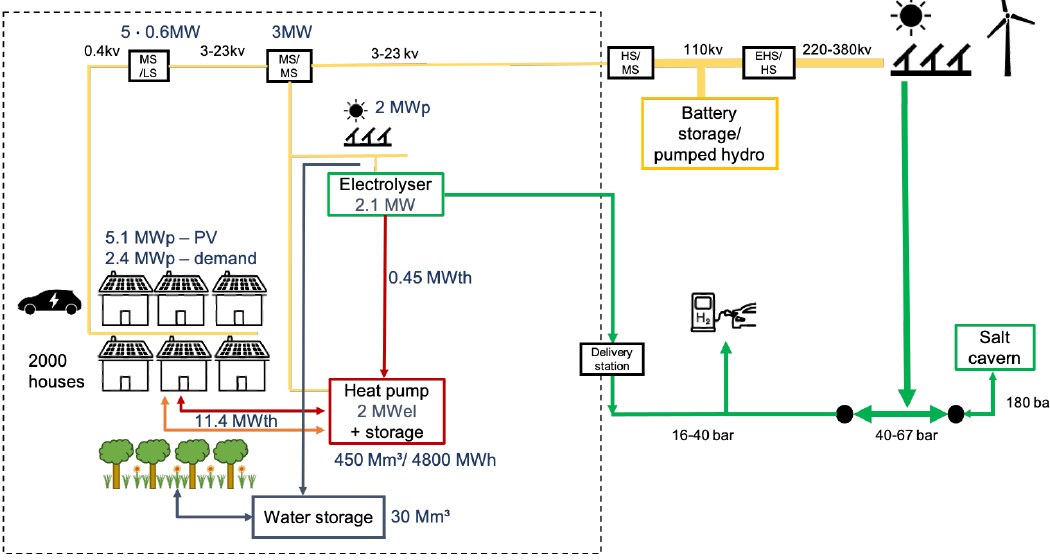
Figure 6. Schematic overview of the power-to-X scenario with both power-to-heat and power-to-hydrogen combined, including using heat from the electrolyzer for the heat storage system. The electricity supply peaks are shaved by the electrolyzer (2.1 MW el ) and the heat pump (2 MW el ). The heat pump produces heat in summer with surface water as a heat source and stores heat locally in aquifers (HT-ATES). The heating demand of the houses is fulfilled by a low-temperature district heating network (40 °C), with booster heat pumps for tap water production.